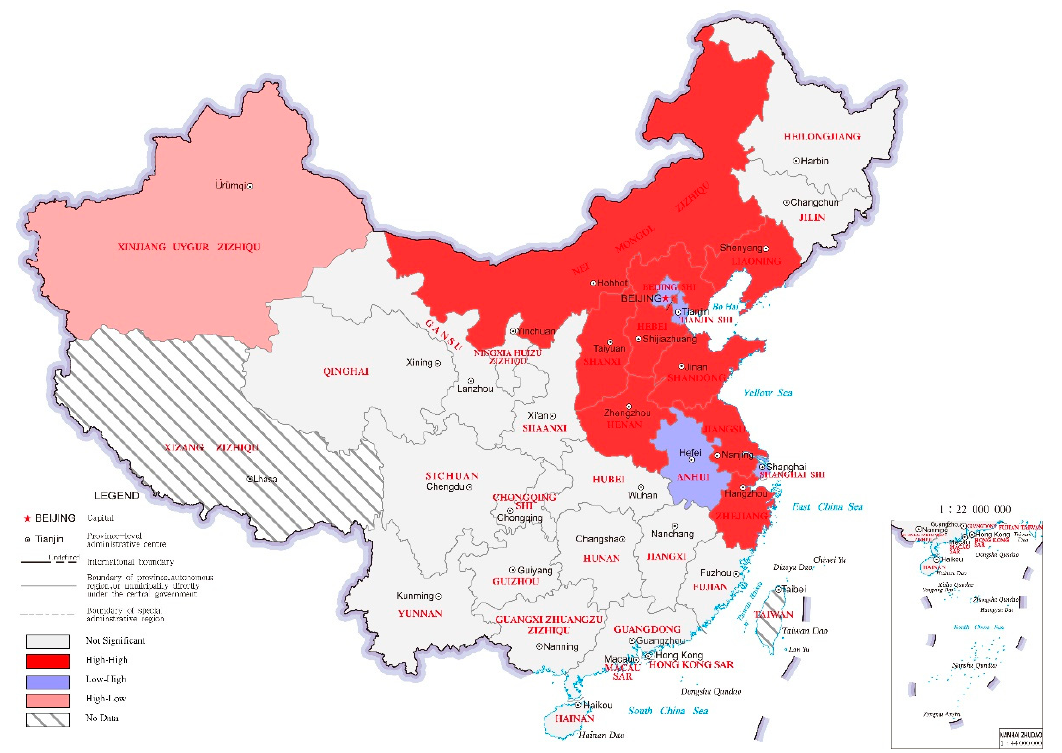
Figure 4. Local autocorrelation of CO 2 emissions in China from 2006 to 2019. The hotspots and coldspots of regional CO 2 emissions were plotted with ArcGIS 10.6 software using Formulas (4)–(6) (see Figure 5).